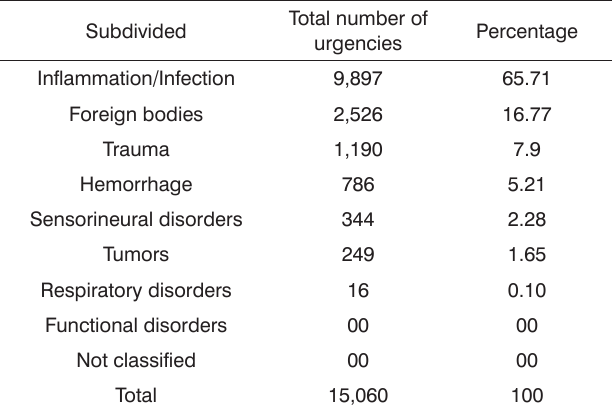
Table 2. Etiology of cases considered as urgent, subdivided according to Cuchi’s 9 criteria.